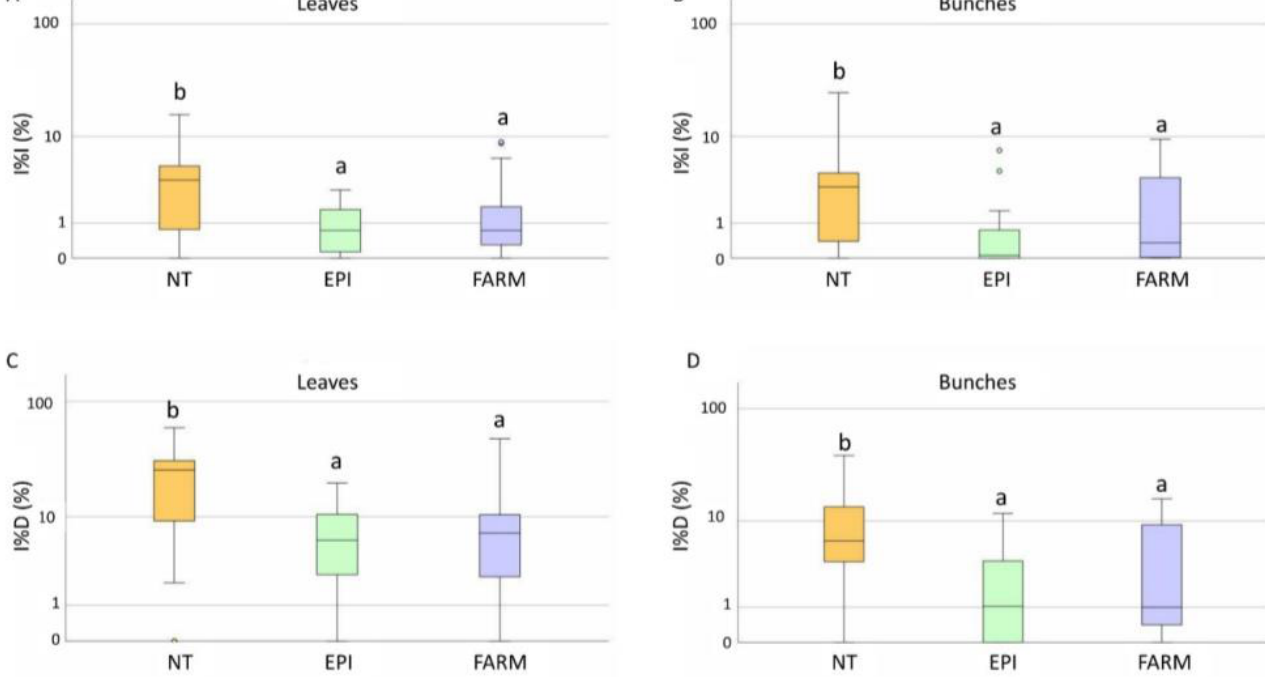
Figure 8. Box plot distribution of the final downy mildew disease severity (I%I) on leaves ( A ) and bunches ( B ), and incidence (I%D) on leaves ( C ) and bunches ( D ) registered during 2021 in the untreated (NT), EPI (EPI), and farmers’ strategy (FARM) plots. Different letters indicate significant differences among samples ( p < 0.05).